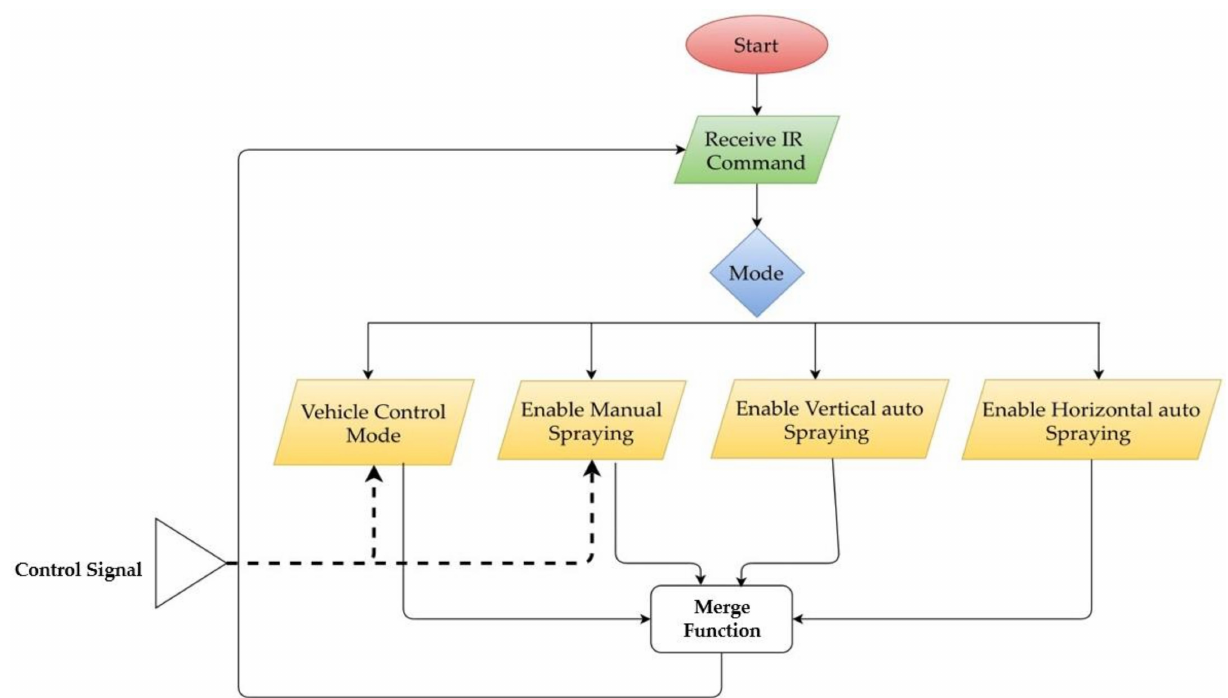
Figure 5. Program flow of the system (Note: IR: infrared; dashed lines represents the control signals to vehicle as well as manual spraying; continuous line represent the IR commands